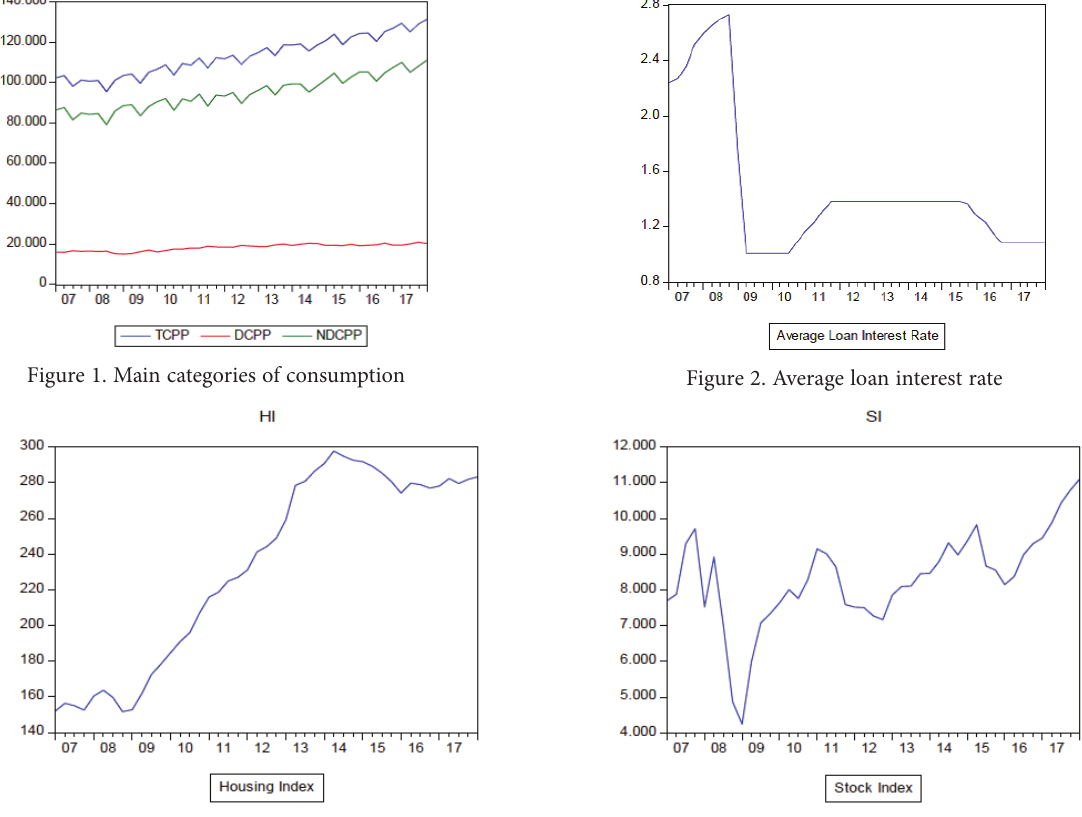
Figure 3. Housing index Figure 4. Stock Table 3. Descriptive statistics for sub-categories of durable goods and non-durable goods consumption